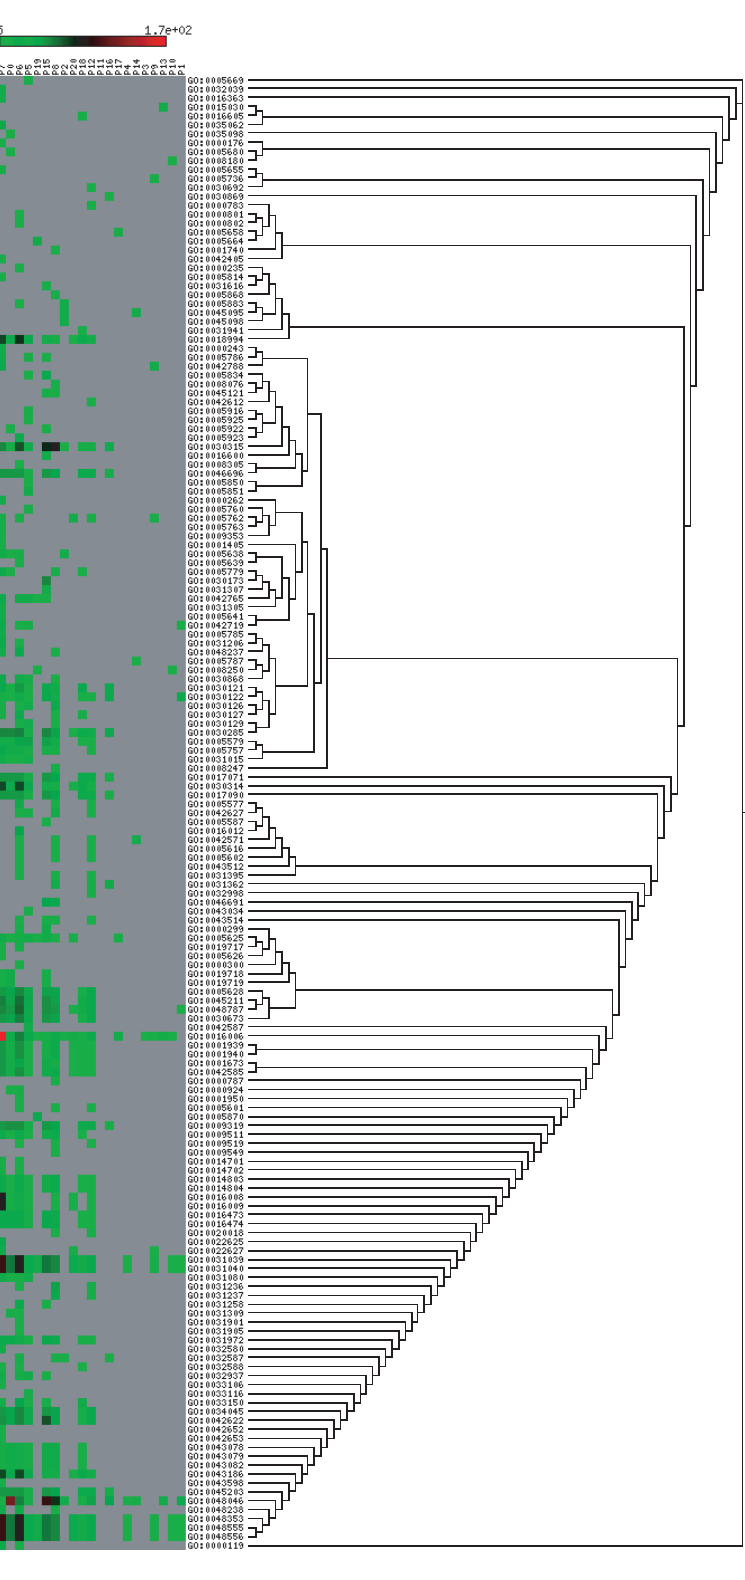
Figure 4. Representative annotation matrices for cellular component. Grey cells in the matrix are not within the outlier of each category. The left part of the tree are generated from GO DAGs not based on the similarities of the rows of the matrix.